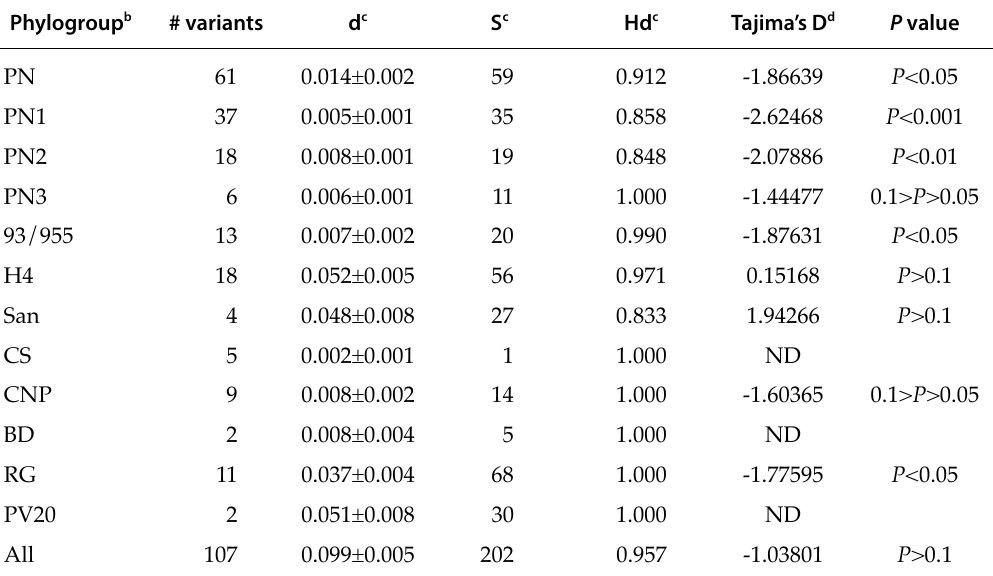
Table 2. (A) Genetic distance within phylogroups and (B) differentiation between phylogroups of Grapevine leafroll-associat- ed virus 2 , and summary of test statistics examined for demographic trends. (A) Genetic distance and test of neutrality within groups